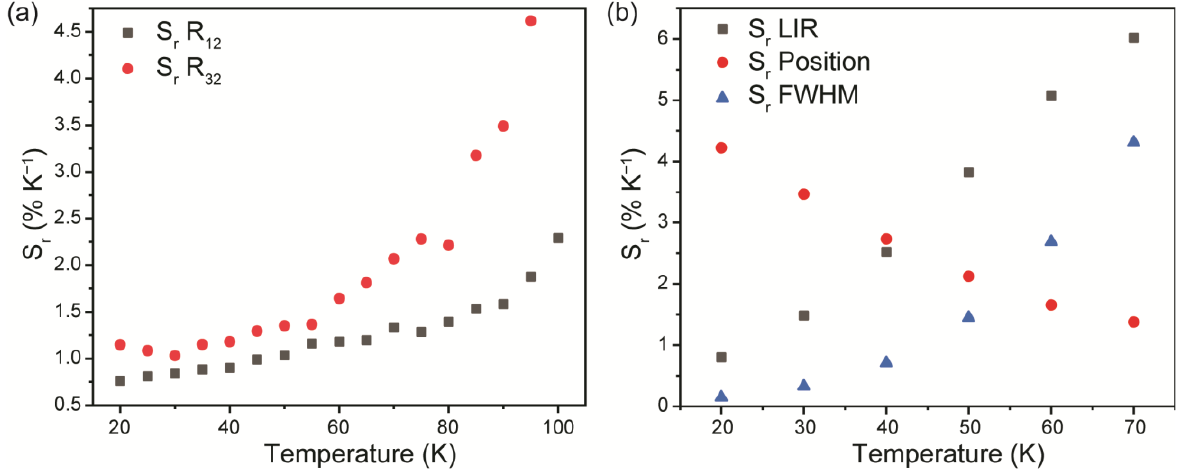
Figure 6. Temperature dependence of S r values for ( a ) Raman and ( b ) luminescence-based optical thermometry.